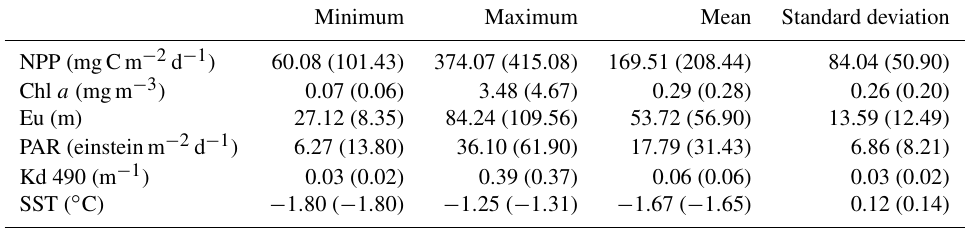
Table 2. Net primary production and bio-optical parameters during the occurrence of the Maud Rise polynya in October and November 2017. Values for November 2017 are given within brackets. NPP: net primary production; Chl a : chlorophyll a ; Eu: euphotic depth; PAR: photosynthetically available radiation; Kd: diffuse attenuation coefficient for downwelling irradiance; SST: sea surface temperature.